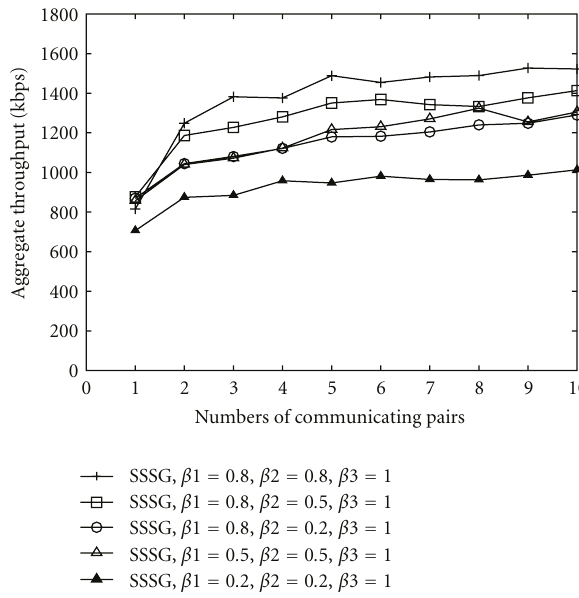
Figure 17: Aggregate throughput of SSSG with 2 channels having PUs’